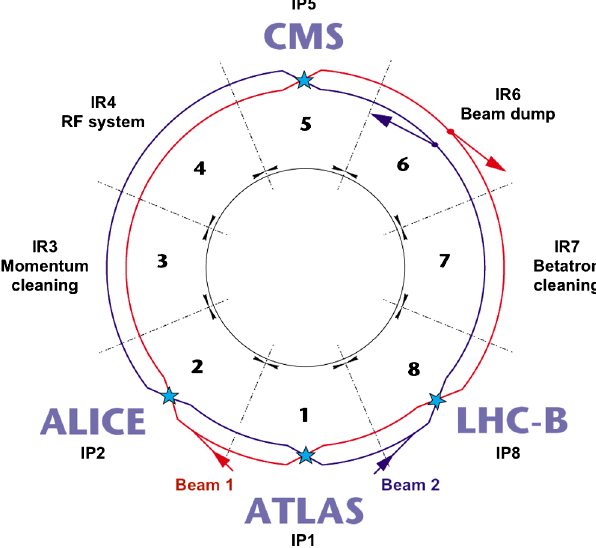
FIG. 1. Schematic layout of the LHC ring.